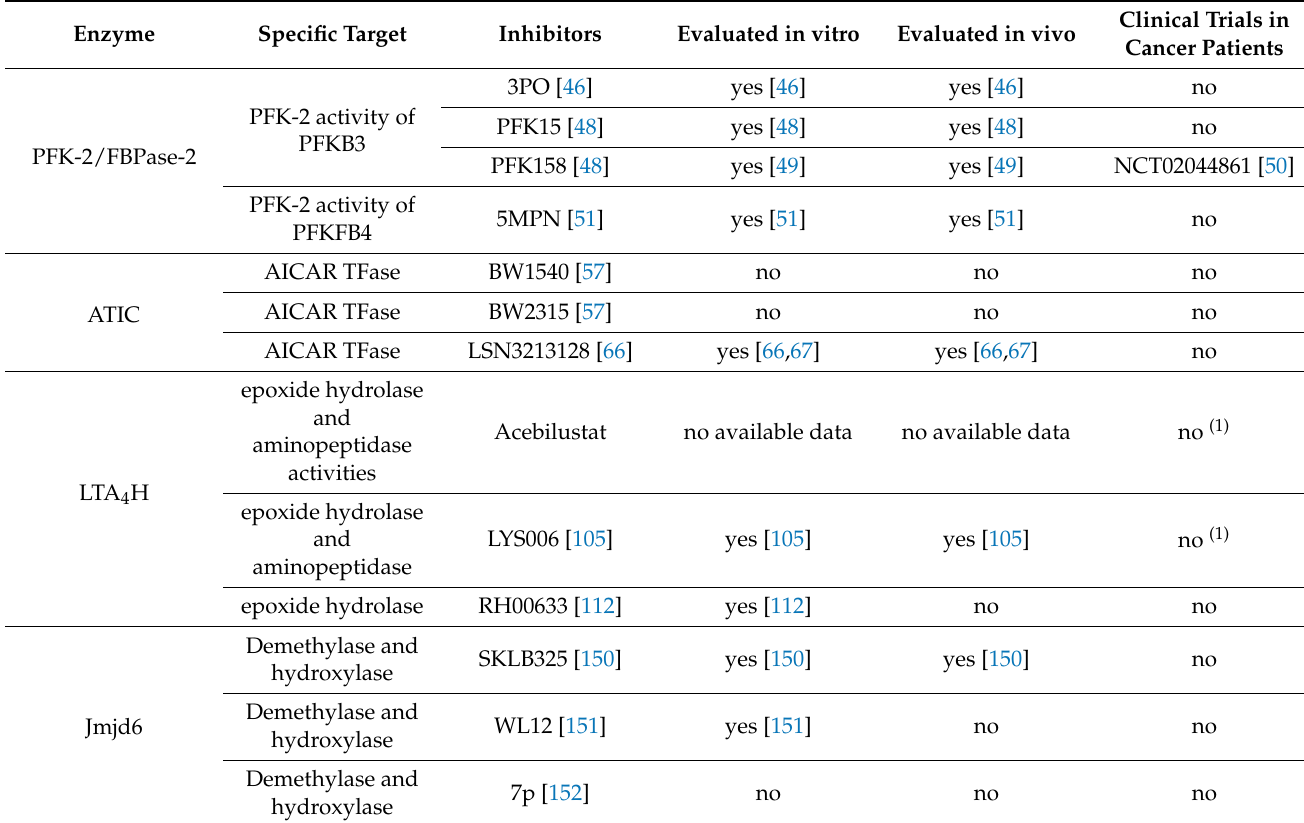
Table 1. Current status of the development of inhibitors targeting PFK-2/FBPase-2, ATIC, LTA 4 H and